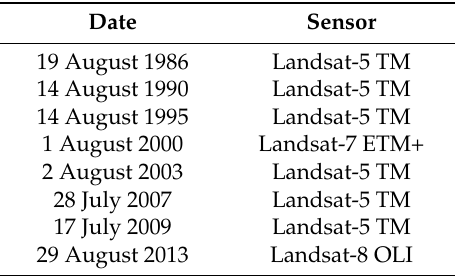
Table 1. Acquisition dates of Landsat